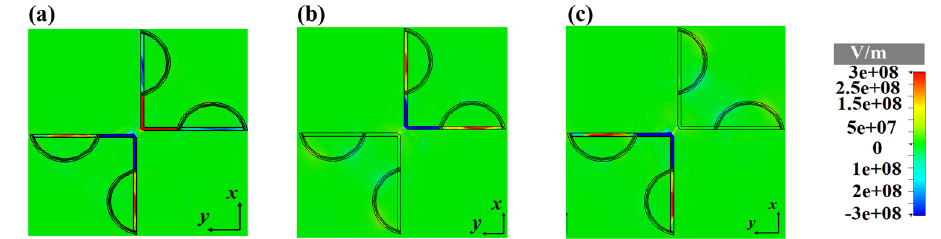
Figure 12. The distributions of the z-component of electric field of smart unidirectional cross dipole nano- antenna at 1550 nm for different states of chemical potential ( a ) µ 1 = µ 2 = 0 eV , ( b ) µ 1 = 0 eV , µ 2 = 0.51eV and ( c ) µ 1 = 0 .51eV , µ 2 = 0 eV .